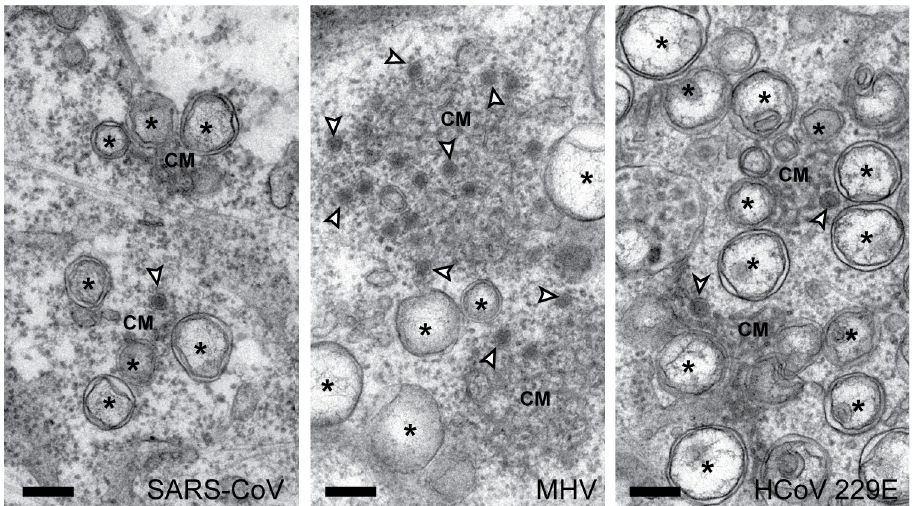
Fig 3. DMSs are induced by diverse beta- and alpha-CoVs. 2D-EM images from 100-nm-thick sections of different mammal cells infected with (from left to right) SARS-CoV (MOI 10, 9 hpi), MHV (MOI 10, 8 hpi), and HCoV-229E (MOI 5, 24 hpi). These time points represent intermediate to late stages in infection [34–36]. Both beta-CoVs (A,B) and the alpha-CoV (C) induce membrane modifications that include not only DMVs (asterisks) and CM but also DMSs (white arrowheads). Scale bars, 250 nm. CM, convoluted membranes; CoV, coronavirus; DMS, double- membrane spherule; DMV, double-membrane vesicle; EM, electron microscopy; ER, endoplasmic reticulum; HCoV- 229E, human coronavirus 229E; hpi, hours postinfection; IBV, infectious bronchitis virus; MHV, murine hepatitis virus; MOI, multiplicity of infection; SARS-CoV, severe acute respiratory syndrome-CoV.